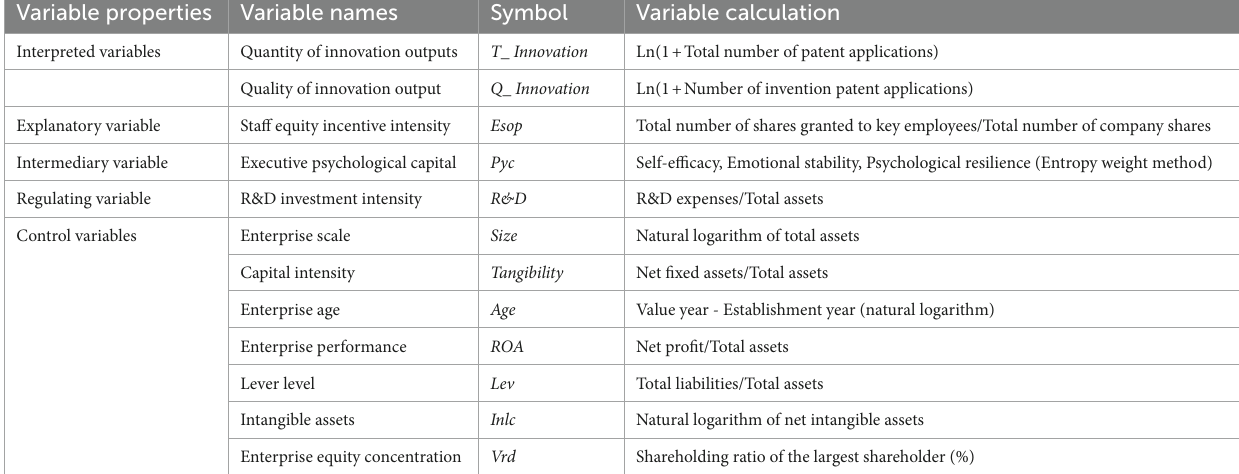
TABLE 2 Variables